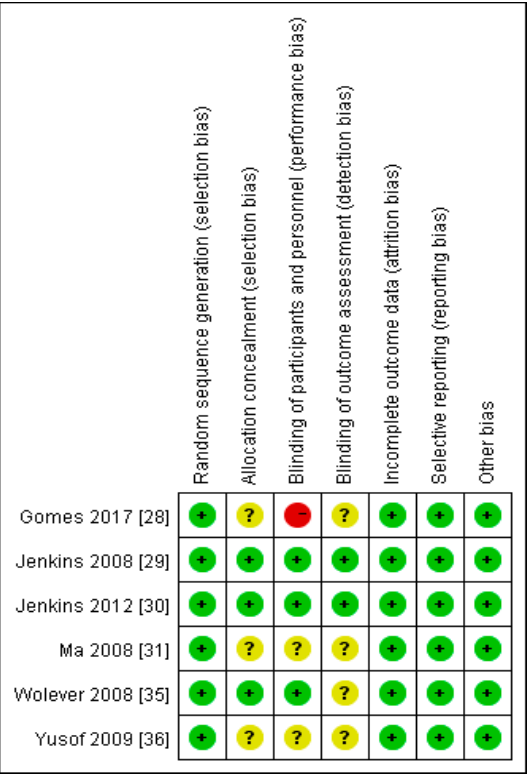
Figure 2. A risk of bias summary.